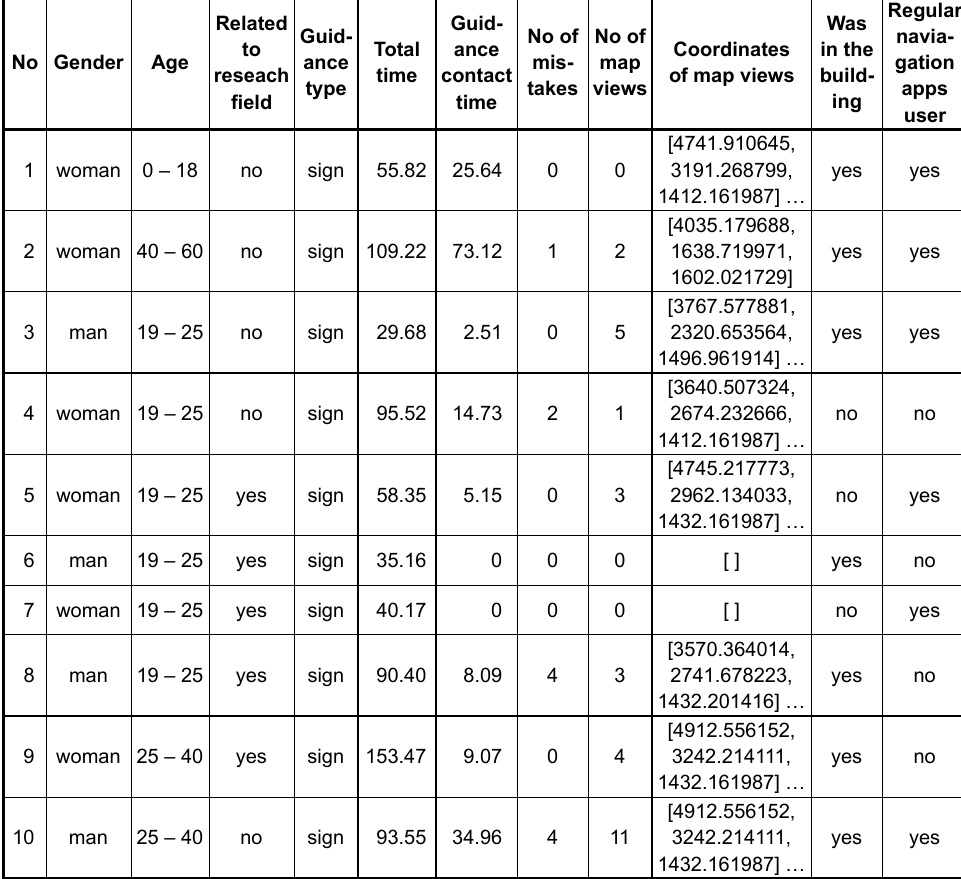
Table 3. Excerpt from the spreadsheet collecting the results of the